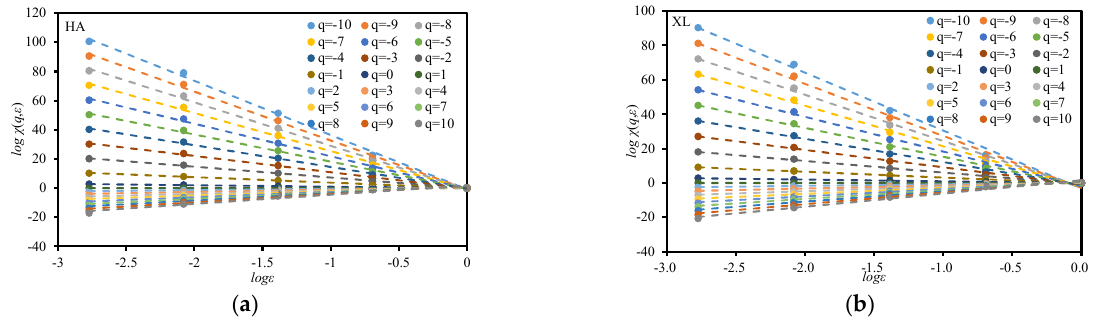
Figure 6. Log–log plots of the partition function versus box scale. (( a ) HA sample; ( b ) XL sample). For multifractals, the slope of the curves on both sides of q = 0 changes obviously, and the pore system is not uniform. The τ q of middle-high rank coal in the Qinshui coalfield presents a nonlinear increasing trend with increasing q , and the τ q - q curve deviates from a straight line and presents a convex feature (Figure 7b), indicating that the pore distribution of middle-high rank coal has a multifractal feature. The generalized dimension spectrum D q - q of medium-high rank coal can be observed as follows: a. The D q - q spectrum of medium-high rank coal shows a monotonically decreasing inverse S -shape. As the absolute value of q increases, the D q - q spectrum curve changes from a strong inverse S -shape to a slightly inverse S-shape and then to near level, and the slope of the fitting curve of the D q - q spectrum decreases gradually; b . The D q - q spectrum of medium-high rank coal intersects at the point (0,1), the capacity dimension D 0 is equal to 1, the infor- mation dimension D 1 is between 0.81 and 0.90, and the correlation dimension D 2 is be- tween 0.75 and 0.89(Table 2). D 0 , D 1, and D 2 of medium-high rank coal meet the require- ments of D 0 > D 1 > D 2 [31], indicating that the pore structure of medium-high rank coal shows multifractal characteristics. Taking q = 0 as the boundary, the D q - q spectrum of me- dium-high rank coal can be divided into two parts: wide branch ( q < 0, sparse region mainly) and narrow branch ( q > 0, dense region mainly). The shape difference of the left and right branches well reflects the complexity of the pore structure in the regions with different densities of medium-high rank coal. The wide left and narrow right of the D q - q spectrum indicate that the pore structure in the sparse region of medium-high rank coal is more heterogeneous. ( a ) ( c ) Figure 7. The relationship of multifractal dimension parameters (a. Generalized fractal dimension spectrum b. mass distribution functions τ(q) c. multifractal singular spectrum).